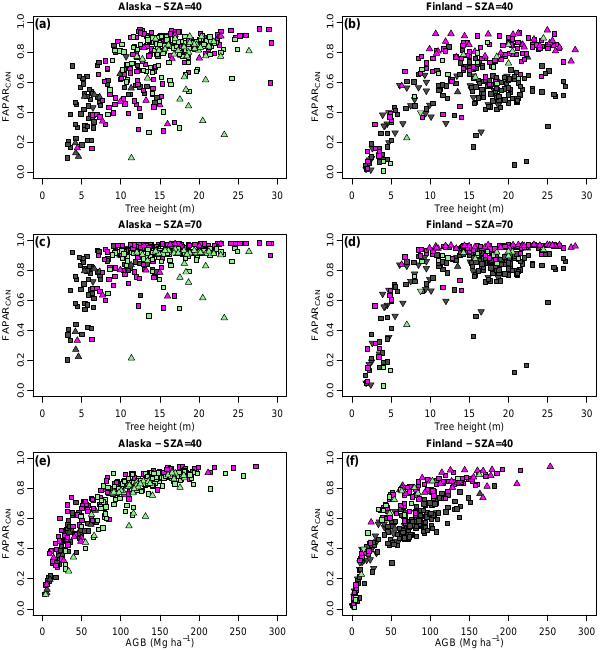
Figure 5. Black-sky FAPAR CAN as a function of tree height (a– d) and AGB (e–f) . Relations to tree height are shown for two SZAs, 40 ◦ (a–b) and 70 ◦ (c–d) , representing solar noon at midsummer and the annual average in the study regions. Left hand column shows the results for the Alaskan data, and right hand column for the Finnish data. The figures show only monospecific plots, i.e., plots in which the basal area proportion of one of the species exceeded 80%. For explanation of the symbols, see legend in Fig. 4.